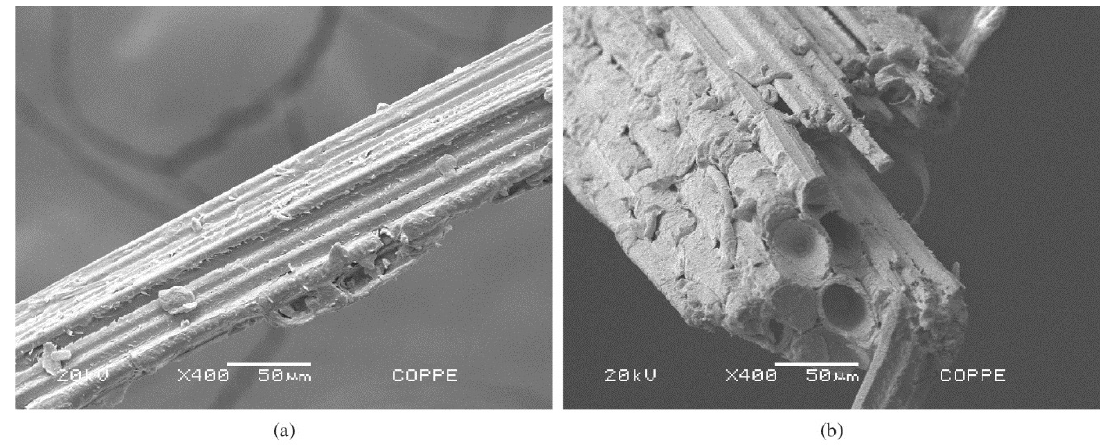
Figure 1. The giant bamboo: (a) SEM of a thin bamboo fiber and (b) fracture tip of a thicker bamboo fiber. Source: